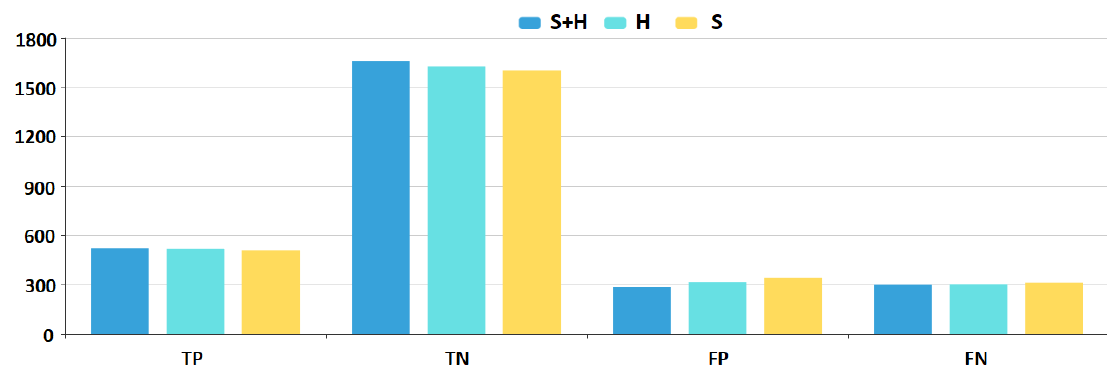
Figure 14. K-nearest neighbors. Table 2. Wilcoxon signed-rank test results of F-measures between models using different feature sets.